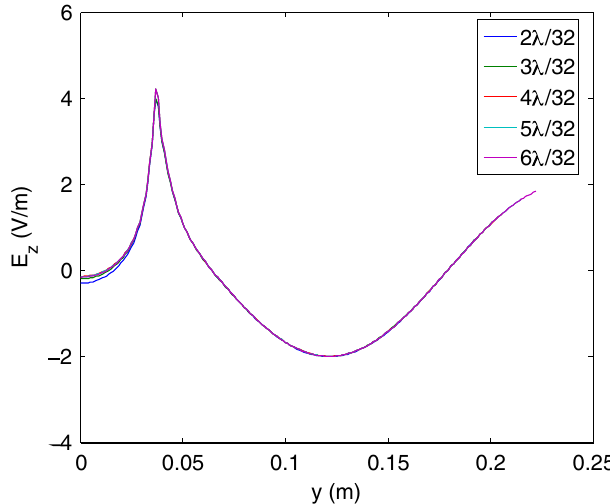
FIG. 4. Radial electric field generated by combining the for- ward and reflected waves for (cid:2) ¼ 1 and t ¼ 0 sec . The fields are evaluated so that the radial field in the coupler is given by E ( V = m ) in that